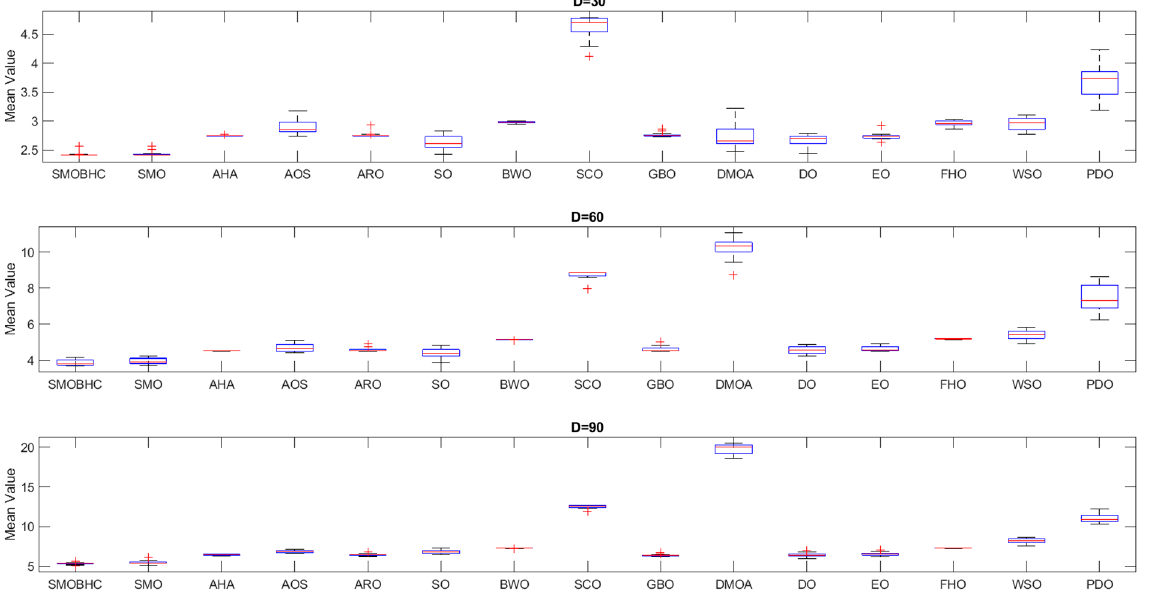
Figure 21. Boxplot graphs of mean values relative to all algorithms for battlefield 3 with 𝐷 = 30 , 60, and 90.